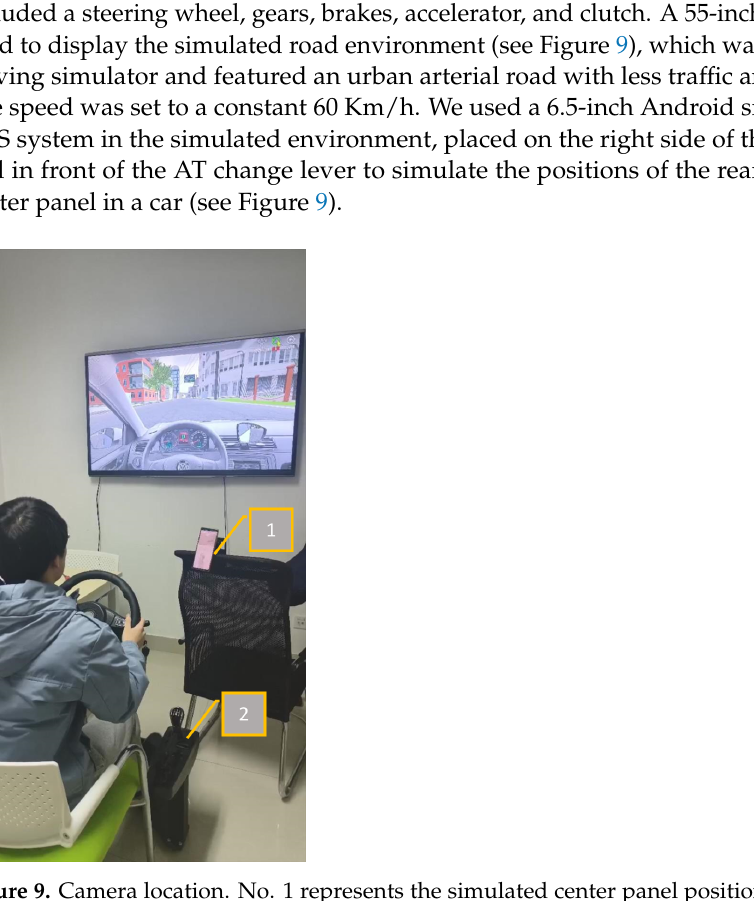
Figure 9. Camera location. No. 1 represents the simulated center panel position in the simulation environment; No. 2 represents the simulated rear console position in the simulation